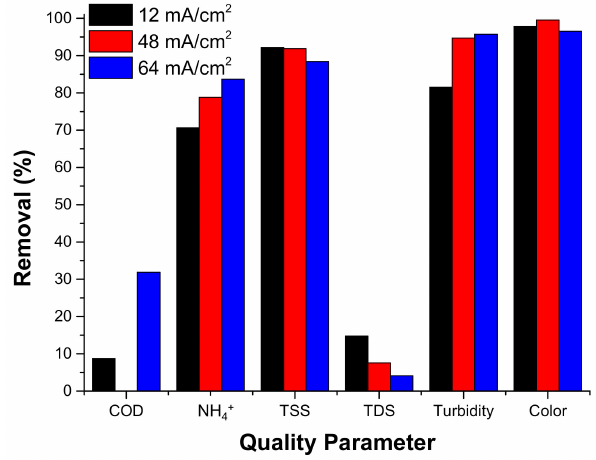
Figure 4. Removal rate of COD, NH 4+ , TDS, TSS, turbidity, and color during variation of current density (pH = 7.5; inter-electrode distance= 1.5 cm; electrolysis time = 120 min; temperature = 20 ◦